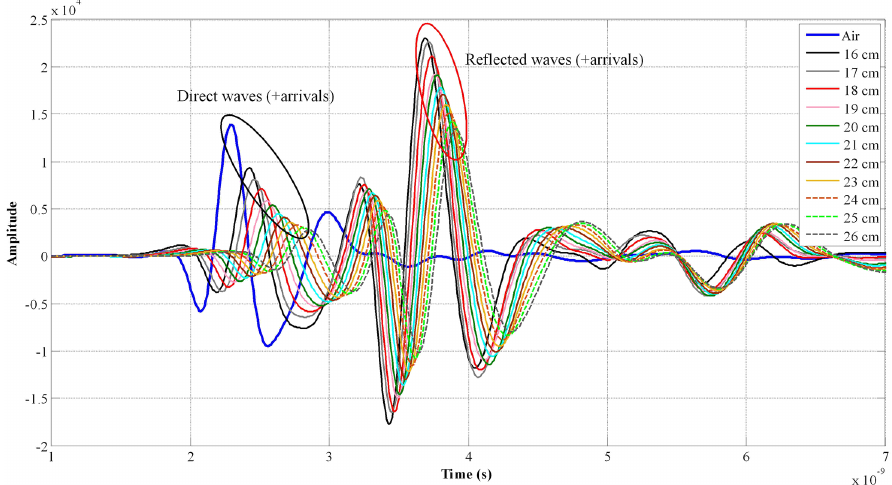
Figure 3. A-scans showing the superposition of the direct-air, direct and reflected waves measured over the sample when the polarisation of the electric field is orthogonal to the fibres and at a 12% humidity level by mass water.